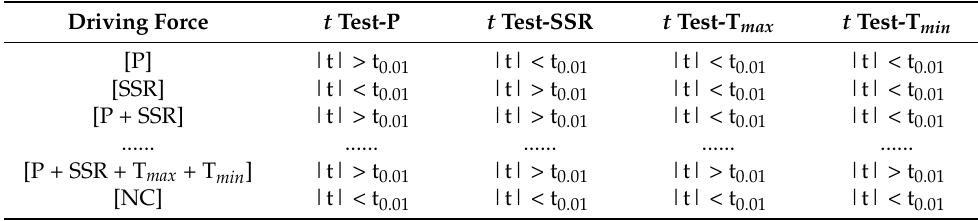
Table 1. Significance-based analysis standards for climate driving forces on